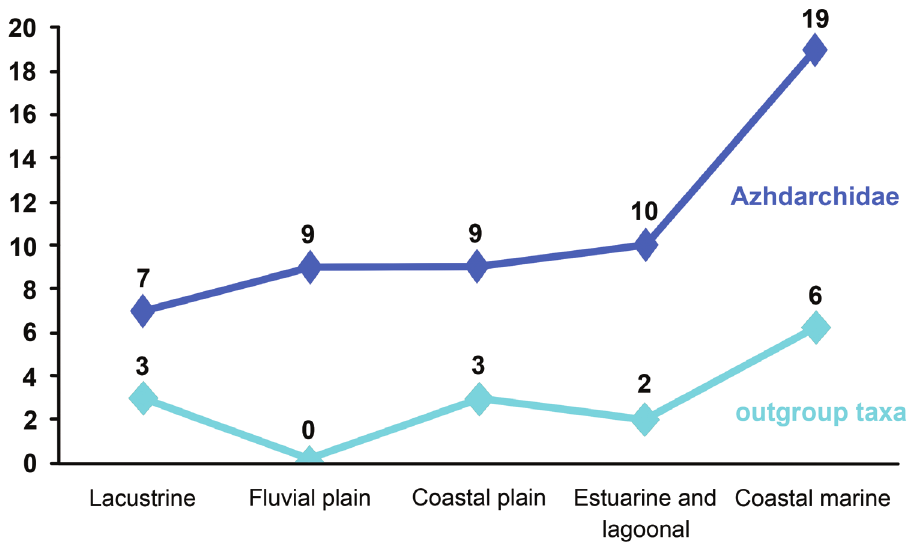
Figure 8. Number of azhdarchid and possible outgroup taxa localities plotted on the